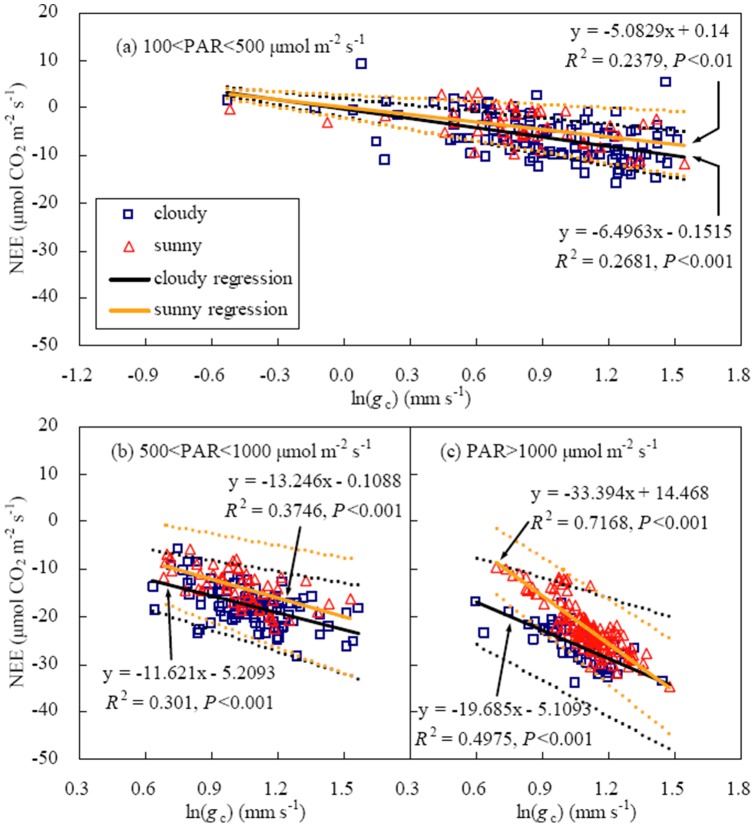
Linear relationship between NEE and logarithmic canopy conductance (g
c) under sunny and cloudy sky conditions (solid lines) in a winter wheat field during the period of large LAI (0.8LAImax<LAI<LAImax).Between the upper and lower dotted lines were 95% confidence intervals.